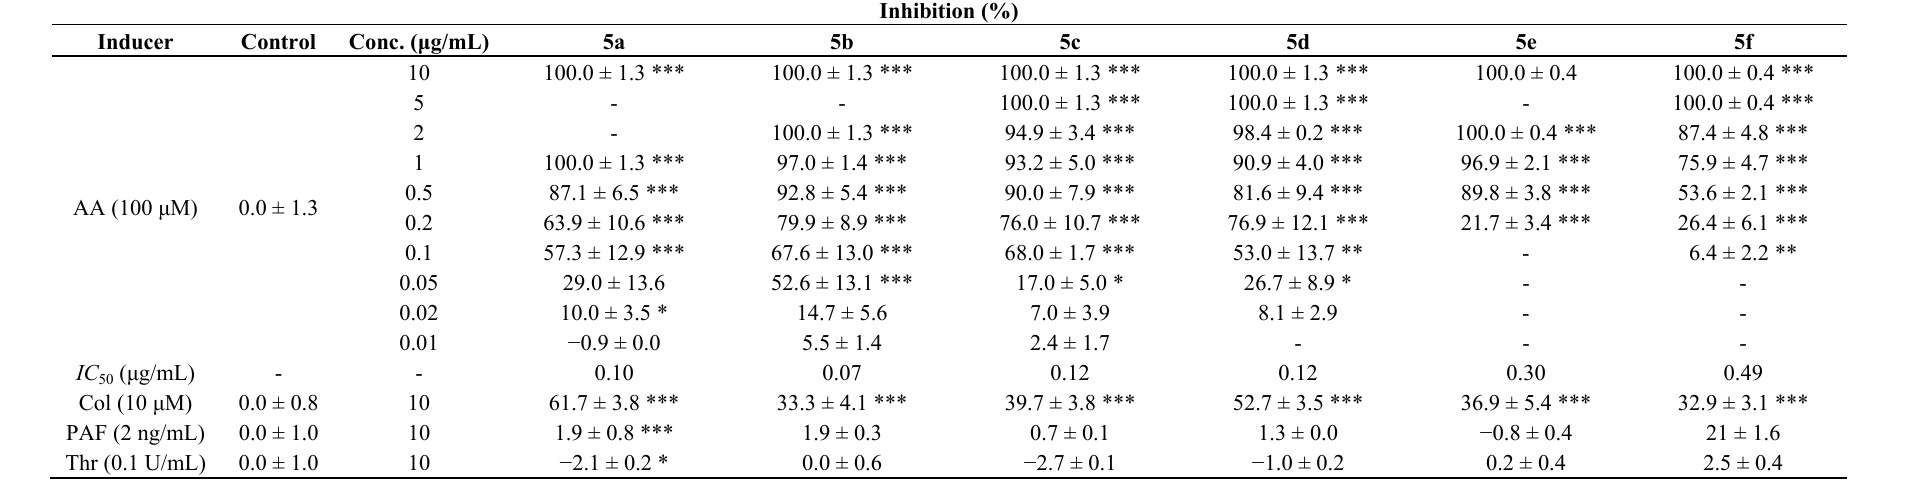
Table 6. Antiplatelet activity of [ n ]-paradols 5a – f .